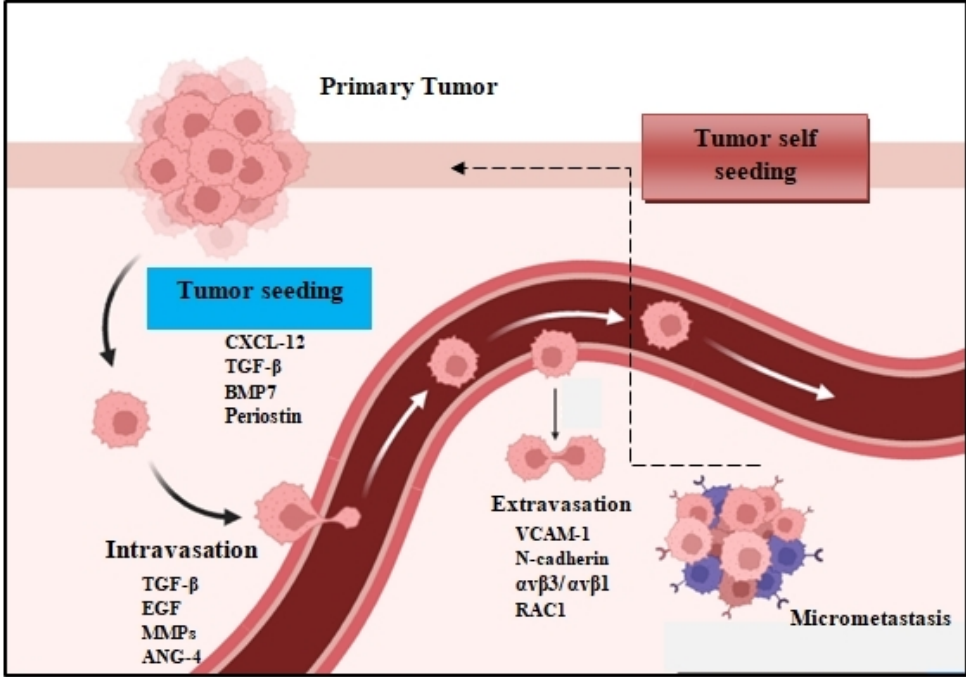
Figure 1. The metastatic colonization cascade. The various steps of metastasis are depicted: intrav ‐ asation, circulation, extravasation, and colonization of distant organs. In many tumors, cancer cells can return to the primary tumor (tumor self seeding) and accelerate its expansion.